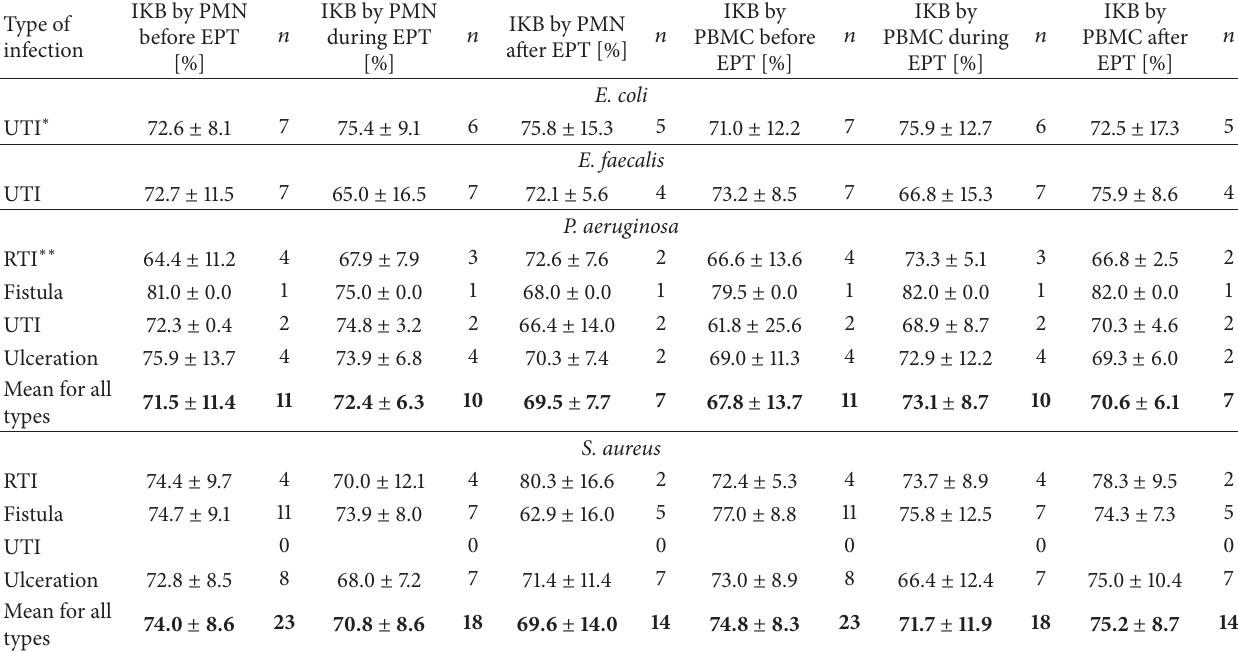
Table 4: Mean intracellular killing of pathogenic strains according to the type of infection (mean ±